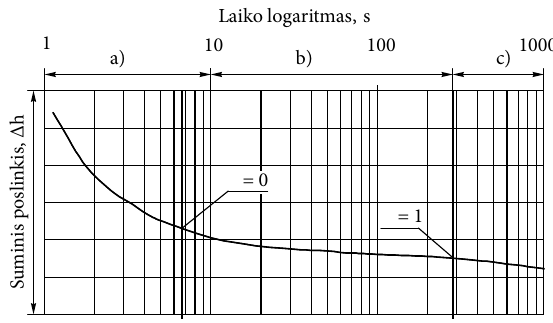
Fig. 1. Final compression: a – primary compression; b – primary consolidation; c – secondary